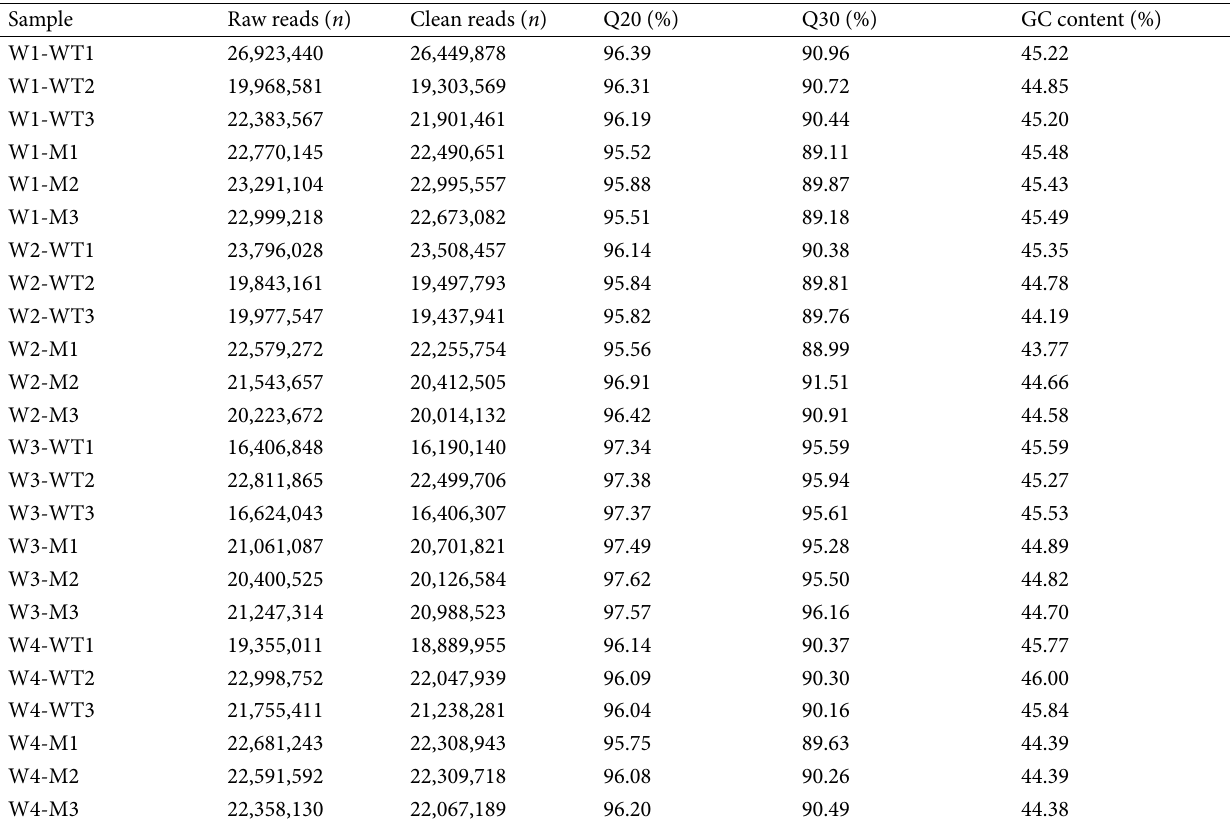
Table 1 Summary of the wild type and double mutant transcriptome data obtained by Illumina sequencing.